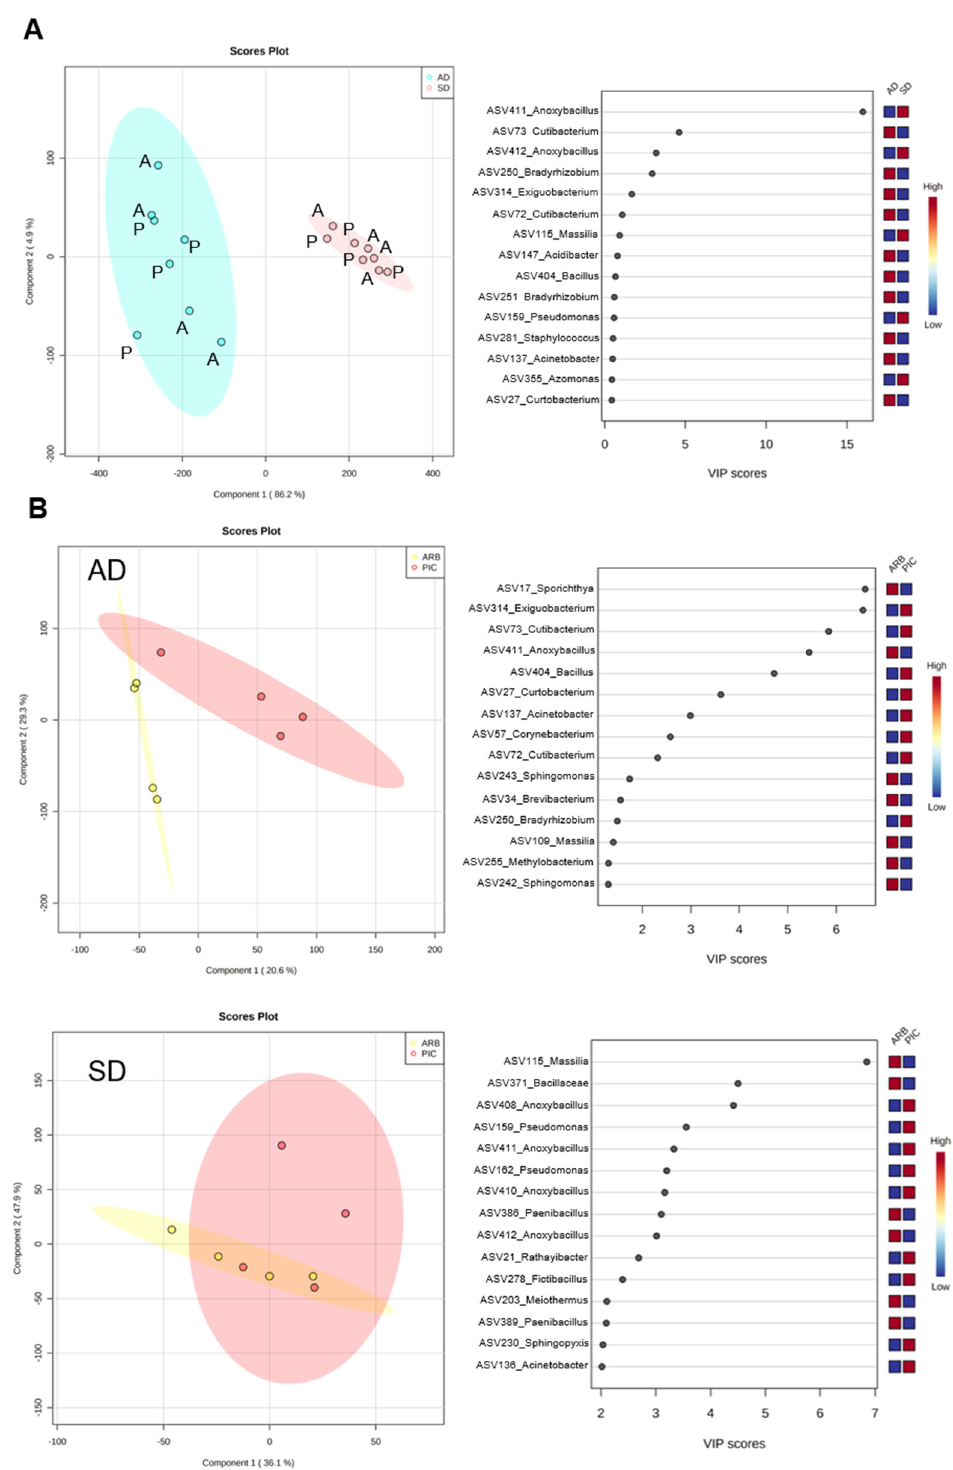
Figure 5. Partial least squares discriminant (PLS-DA) 2D score plot and loading importance in projection (VIP scores) in the first PLS-DA component of microbiome profile of olive xylem sap of plantlets (SD) and adult (AD) olive trees of ‘Picual’ (PIC) and ‘Arbequina’ (ARB) genotypes. ( A ) Combined analysis of all olive cultivars and plant age combinations. ( B ) Separate analysis by olive plant age.